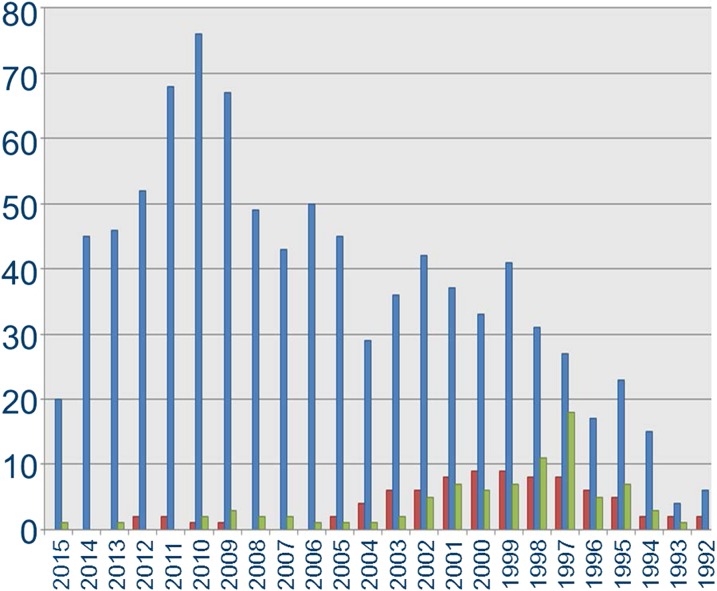
Pipeline of ET receptor antagonists measured by papers in PubMed (blue bars), papers with ChEMBL entries in Europe PubMed Central (red bars) and patents (green bars) in PATENTSCOPE with ET receptor antagonists combined with patent classification C07D (code for medicinal chemistry) (Bento et al. 2014).